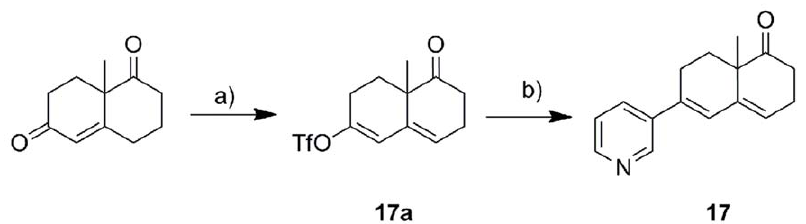
Figure 6. Reagents and conditions. a) Method A: Tf 2 O, CH 2 Cl 2 , 2,6-di-tert-butyl-4-methylpyridine, 2 h; b) Method B: Pd(PPh 3 ) 4 , pyridine-3-boronic acid, Na 2 CO 3 , DME, H 2 O, 90 u C, 2 h.